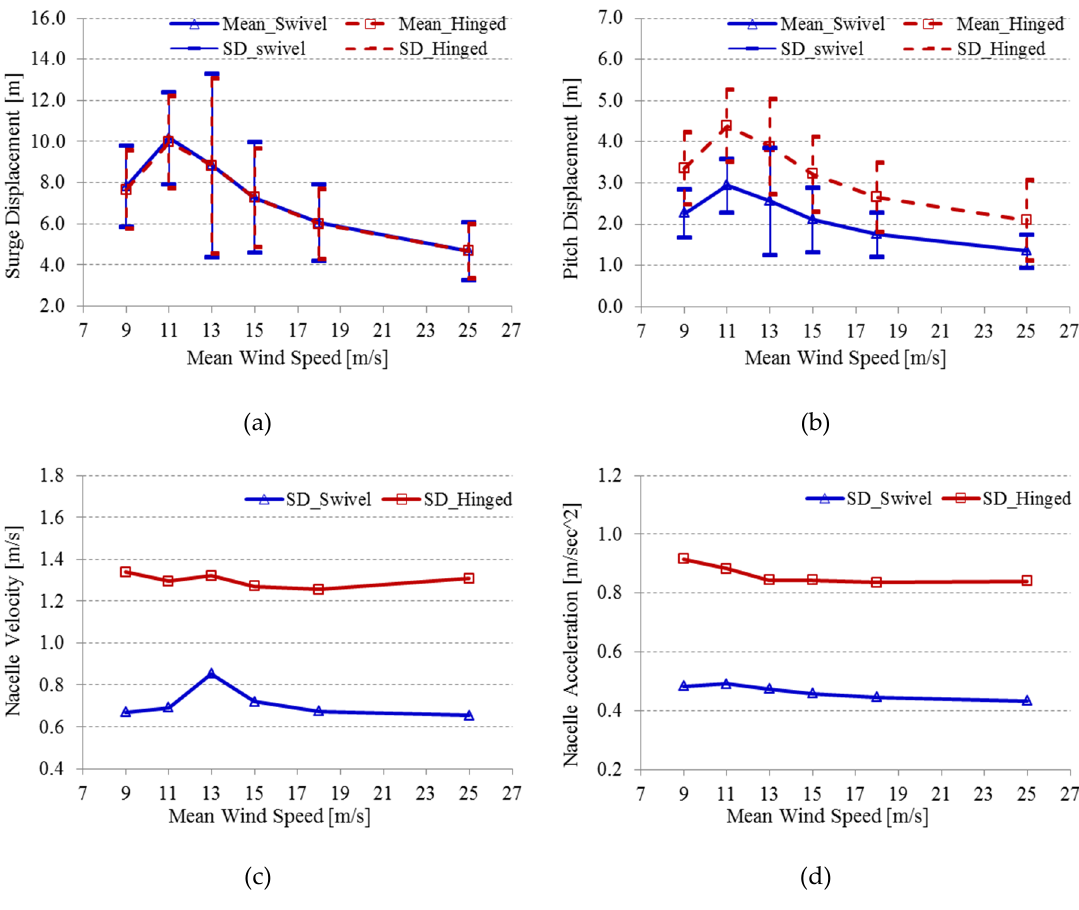
Figure 14. Wind effect on surge/pitch motions and turbine performance: ( a ) Surge motion. ( b ) Pitch Figure 14. Wind e ff ect on surge / pitch motions and turbine performance: ( a ) Surge motion. ( b ) Pitch motion. ( c ) Nacelle Velocity. ( d ) Nacelle Acceleration. SD: standard deviation. motion. ( c ) Nacelle Velocity. ( d ) Nacelle Acceleration. SD: standard